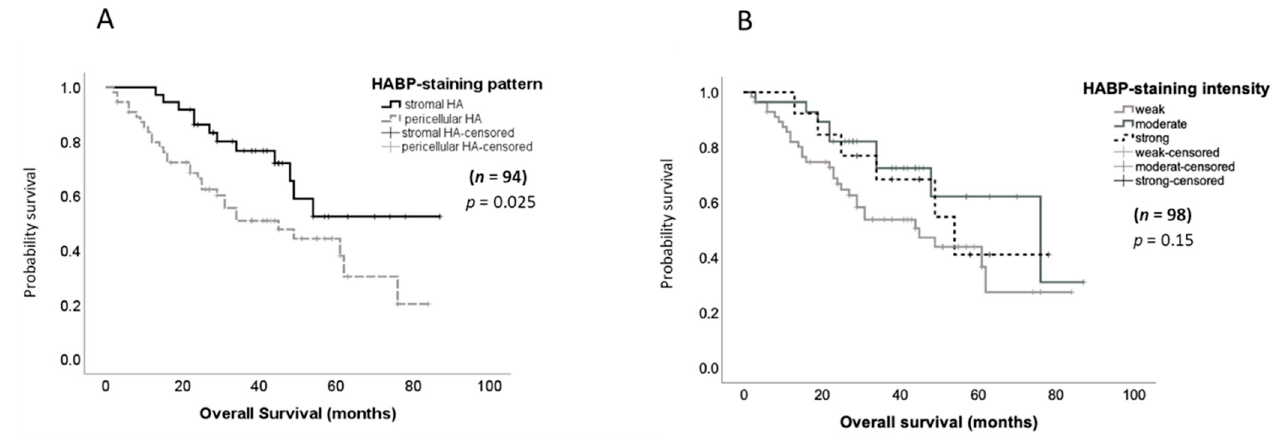
Figure 2. Kaplan–Meier analysis of overall survival based on HABP-staining intensity and staining pattern. ( A ) Kaplan–Meier analysis showed a significant correlation of pericellular ovarian cancer-cell HA deposition with shorter overall survival. ( B ) No significant association of HA-deposition intensity with overall survival including all primary tumors could be found. p values after log-rank tests are shown; p < 0.05 was regarded as significant.